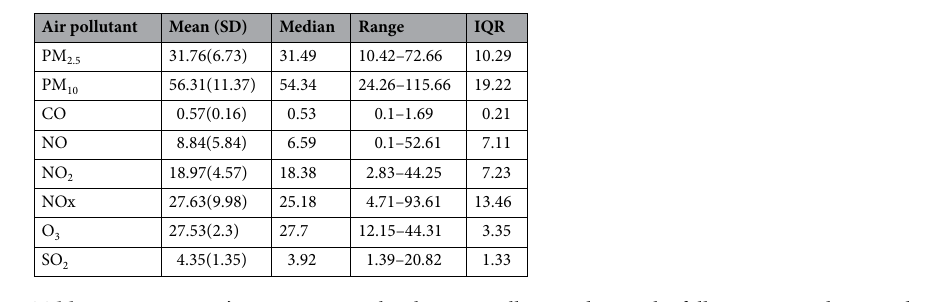
Table 2. Participants’ mean exposure levels to air pollutants during the follow-up period. IQR = the 75th percentile–the 25th percentile.